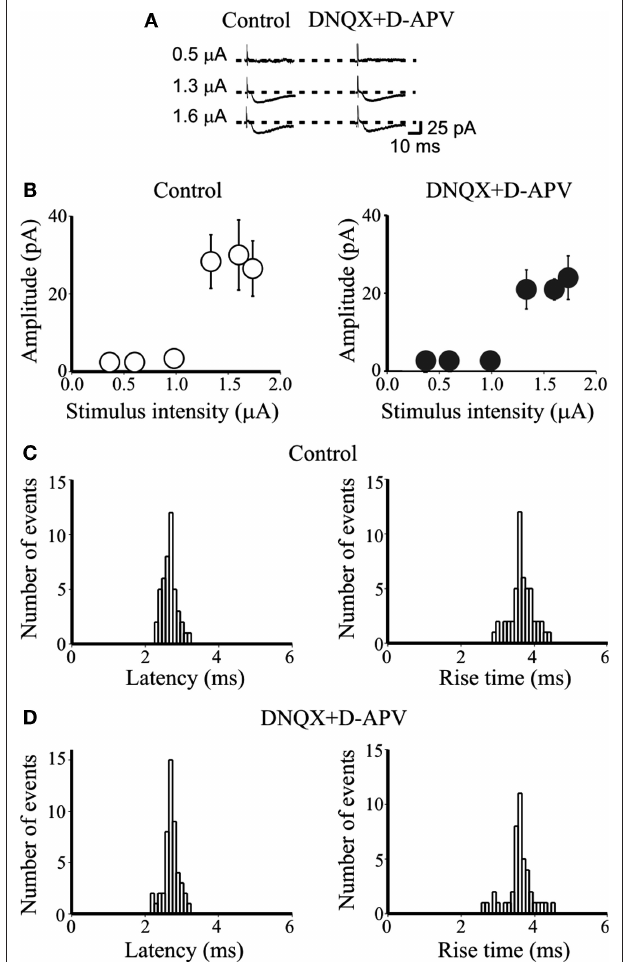
FIGURE 1 | DNQX and D-APV do not modify the latency and rise time of unitary synaptic currents evoked in principal cells by minimal stimulation of granule cells in the dentate gyrus. (A) Unitary synaptic currents evoked in a CA3 pyramidal cell at P4 with different stimulation intensities before (left, control) and during application of DNQX (20 μ M) and D-APV (50 μ M, right) from a holding potential − 70 mV. Each trace is the average of 15–20 responses (including failures). (B) Peak amplitudes of synaptic currents represented in (A) are plotted as a function of stimulus intensities. Bars are SEM. Latency and rise time distributions of individual currents evoked in a CA3 pyramidal cell by minimal stimulation of granule cells in the dentate gyrus in the absence (C) and in the presence (D) of DNQX and D-APV. Note that in the presence of DNQX and D-APV the unimodal distribution of latencies and rise times of individual responses did not